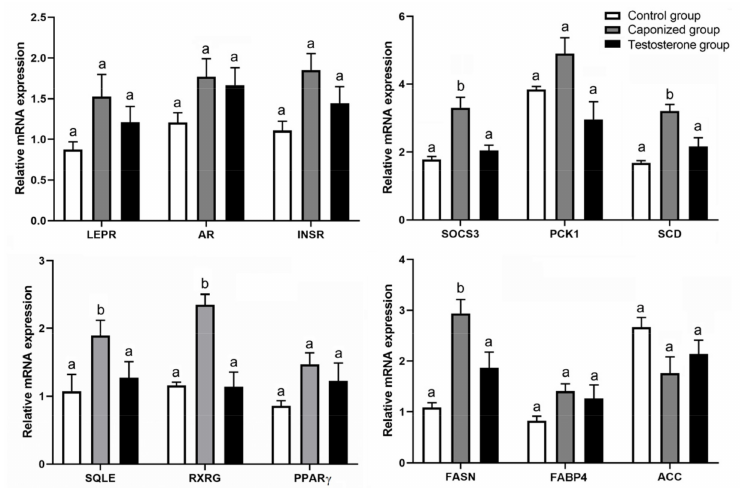
Figure 4. Genes’ mRNA levels relative to β -actin , LEPR , AR , INSR , SOCS3 , PCK1 , SCD , SQLE , RXRG , PPAR γ , FASN , FABP4 , and ACC of liver tissues in the control, the caponized group, and the testosterone group. Data are shown as mean values ± standard error of the mean. Vertical bars represent the standard errors of the mean. Different letters above the bars denote significant differences ( p < 0.05).